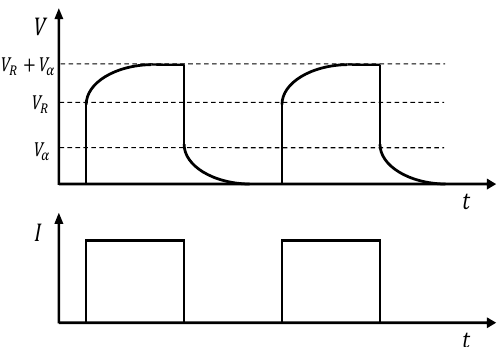
Figure 1. Typical TEM voltage profile using transient method: applied current I ( Bottom ) and resulting voltage V ( Top ) vs. time.